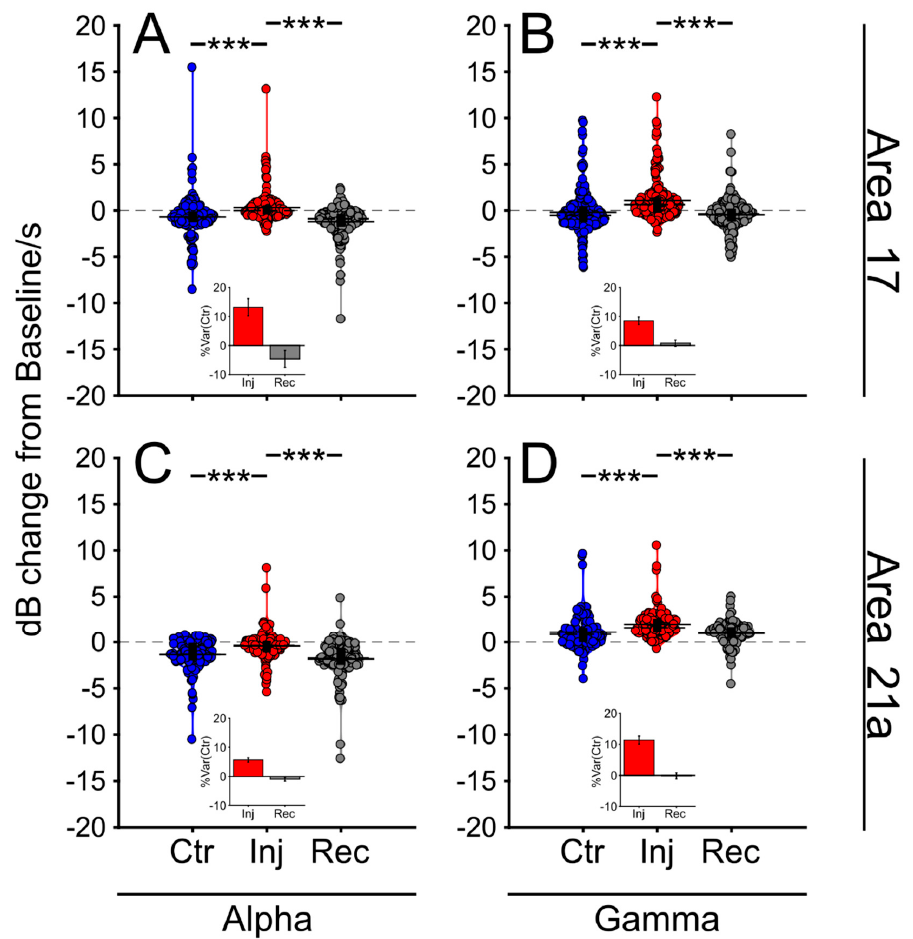
Figure 4. Global oscillatory cortical responses before (Ctr), during (Inj) and after (Rec) LPl inactivation. Comparison of the amplitude of alpha- ( A ) and gamma waves ( B ) across conditions for cortical signals in area 17. Comparison of the amplitude of alpha- ( C ) and gamma waves ( D ) across conditions for cortical signals in area 21a. Insets show the %Var(Ctr) of the Inj and Rec periods. *** P < 0.001.